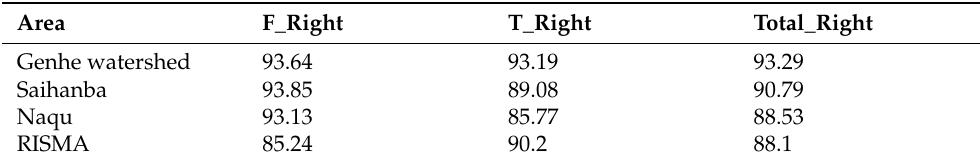
Figure 9. The classification accuracies of F/T new at each site from June 2017 to May 2019 in the Genhe watershed. Table 5. Classification accuracy (%) statistics for F/T new over four study